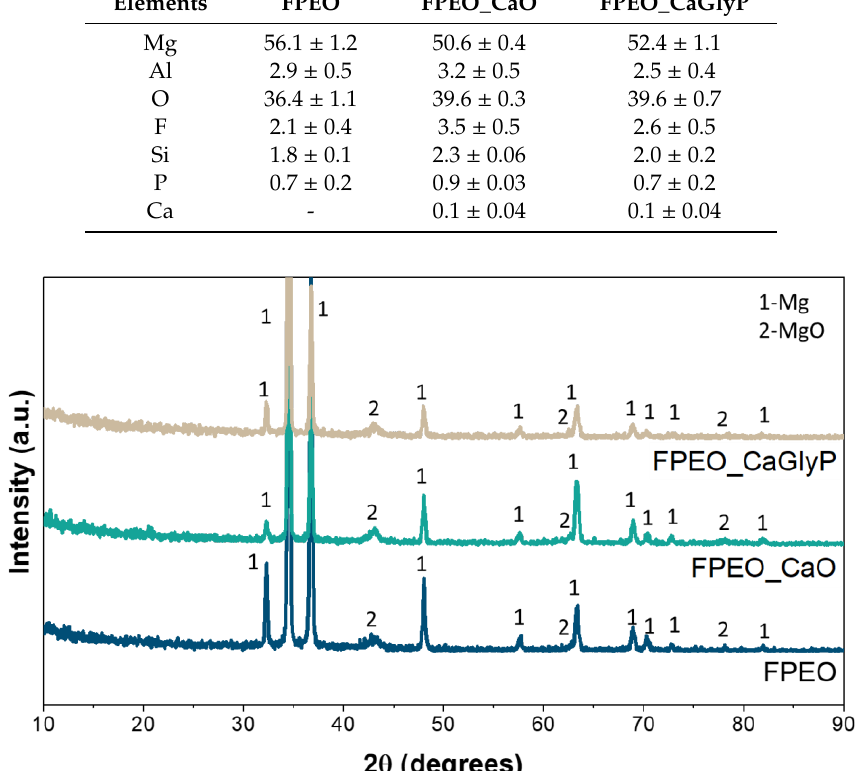
Table 4. Averaged results of the local EDS surface analysis of the coatings (at.%).